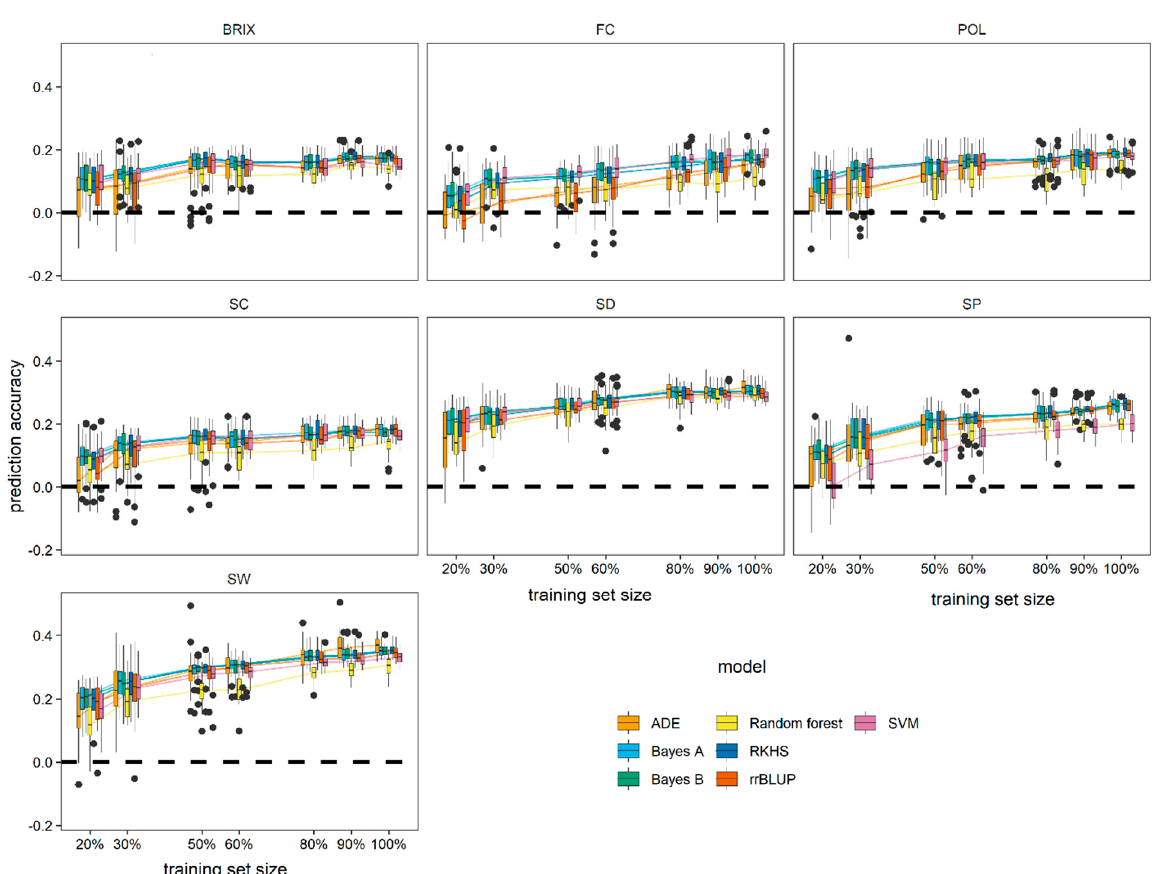
Figure 7. The effect of training population size (percentages) on genomic selection (GS) prediction ability for seven yield- and sugar-related traits: Brix, fiber content (FC), pol, sucrose content (SC), stalk diameter (SD), stalk population (SP), and stalk weight (SW). The plant cane phenotypic data were used.